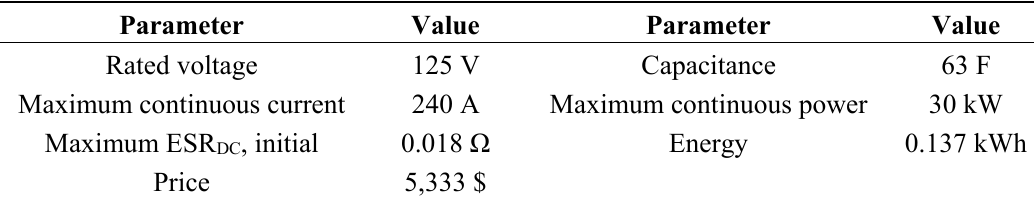
Figure 8. The circuit structure of super-capacitor ESS. Table 3. Parameters of super-capacitor module